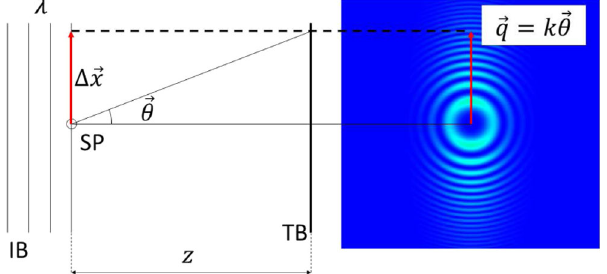
FIG. 4. Geometry relating Fourier wave vectors ⃗ q to transverse displacements Δ ⃗ r . IB represents the incoming beam of wave- length λ , SP the scattering particle and TB the transmitted